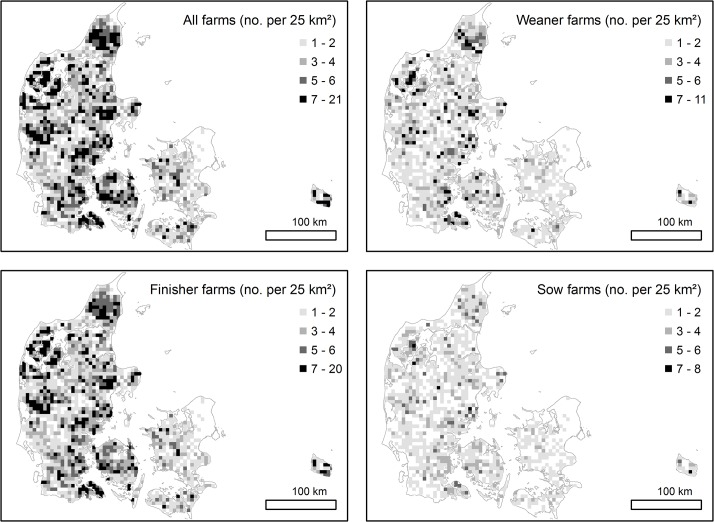
Map of the Danish indoor commercial pig farm density.“All farms” illustrate the geographical distribution of all 6,143 indoor commercial pig farms in Denmark. Maps denoted “weaner farms” (2,886), “finisher farms” (5,417) and “sow farms” (2,062) illustrate farms holding the respective age groups. Colors indicate number of farms present in each square (5*5 kilometer).